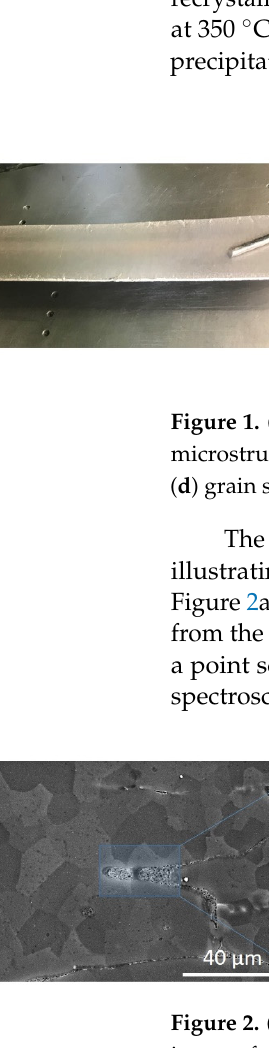
Figure 2. ( a ) Secondary electron image of the annealed microstructure of LX41 alloy, ( b ) magnified image of the area highlighted in ( a ) showing second ‐ phase precipitation, ( c ) energy dispersive X ‐ ray spectroscopy (EDS) results for a representative precipitate in ( b ) identifying a Mg ‐ Ca phase in the Mg matrix. The spot in ( b ) shows an example of an EDX point scan